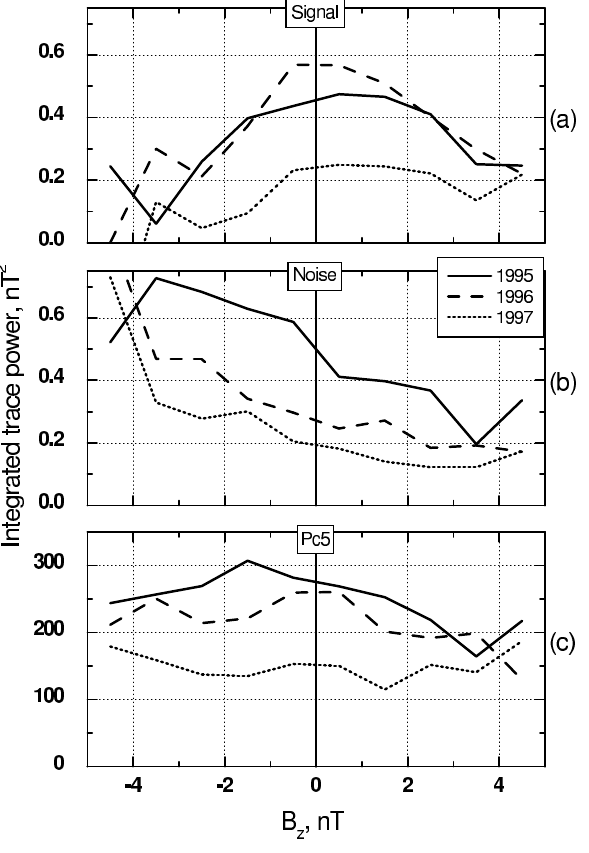
Fig. 11. Dependence of integrated trace power at Davis over 1995- 1997 on solar wind velocity (a) for all B z and (b) for B z >